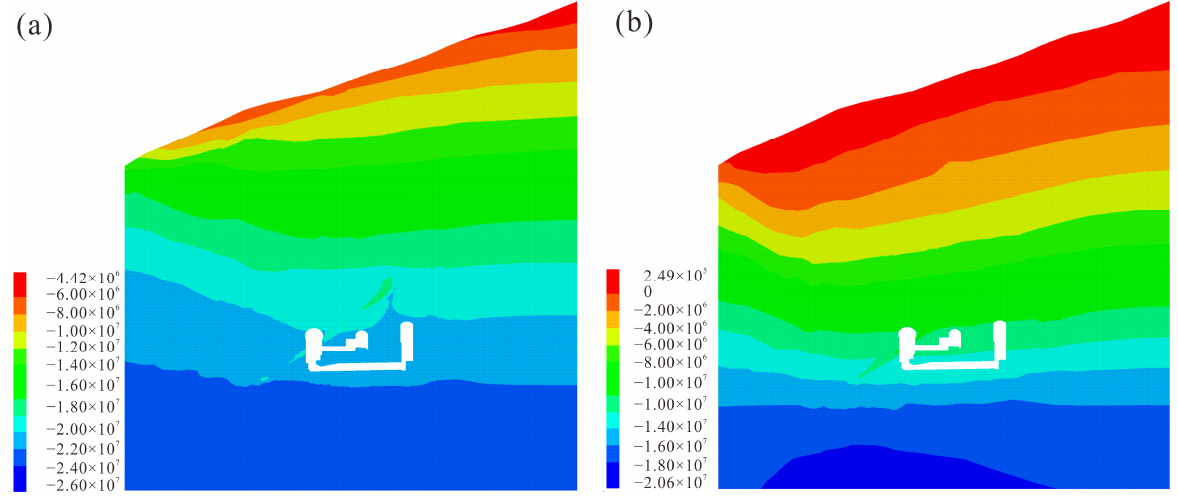
Figure 7. Stress distribution in the cross-section of the main powerhouse. ( a ) the first principal stress, ( b ) the third principal stress.